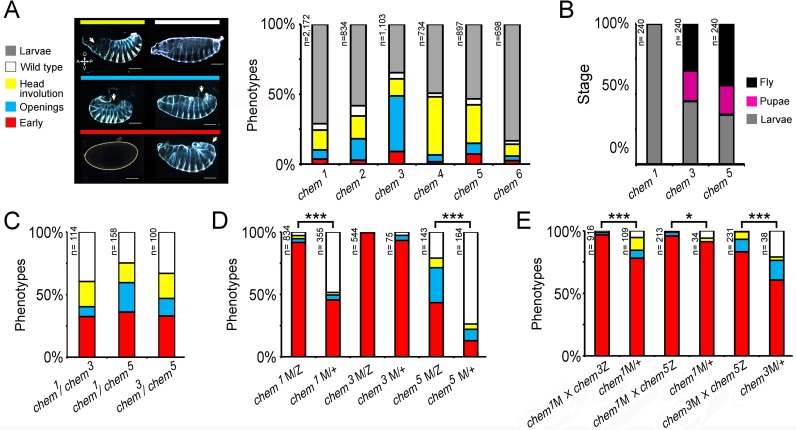
A genetic screen yields new chem alleles.(A) Shows the percentage of embryonic lethal phenotypes of six different chem mutant alleles, and the percentage of surviving mutant first instar larvae. n for each genotype is marked to the left of each column. The different cuticular phenotypes are illustrated in the left hand side panel. Anterior is to the left, and dorsal is up. Most mutant embryos that die with cuticular phenotypes have dorsal holes (either dorsal open or head involution defective). Scale bar is 100 micrometers. (B) Homozygous mutant embryos were selected from balancer-containing siblings by virtue of lack of GFP expression (the balancers used in these experiments all had embryonic GFP expression). Surviving first instar mutant larvae were selected from egg lays, and cultured in fresh food vials, and scored for death of larvae and pupae, and eclosing adults. n = 240 larvae per genotype. For (C–E) color code is the same as in (A), and n is written to the left of the corresponding column. (C) chem heteroallelic combinations show the same embryonic phenotypes as chem homozygous mutants. The graph depicts dead embryos phenotypes. Surviving larvae die before reaching the adult stage. In (D–E) ‘M’ refers to maternally supplied chem germline clone allele; ‘Z’ refers to paternally provided mutant chem allele, and ‘+’ refers to a wild type paternally supplied chem allele (paternal rescue). (D) chem germline clones have very early embryonic phenotypes, much stronger than corresponding homozygous zygotic mutants. Notice that in chem3 germline clones all embryos have early lethal phenotypes. Paternal rescue with a wild type chem allele has a significant effect (reduction of severity of mutant phenotypes) for chem1 and chem5. (E) Heteroallelic mutant combinations of mutant germline clones and paternally provided chem alleles, with and without paternal rescue, show similar embryonic early phenotypes as homozygous mutants. Paternal rescue is significant for all combinations tested. In (C) and (E) we studied the chem1 mutant allele in heteroallelic combination with chem3 and chem5, which have different genetic backgrounds, making very highly improbable that a putative common second site mutation would be responsible for the observed phenotypes. For all figures, significance is as follows: * p ≤ 0.05, ** p ≤ 0.001, *** p ≤ 0.0001.